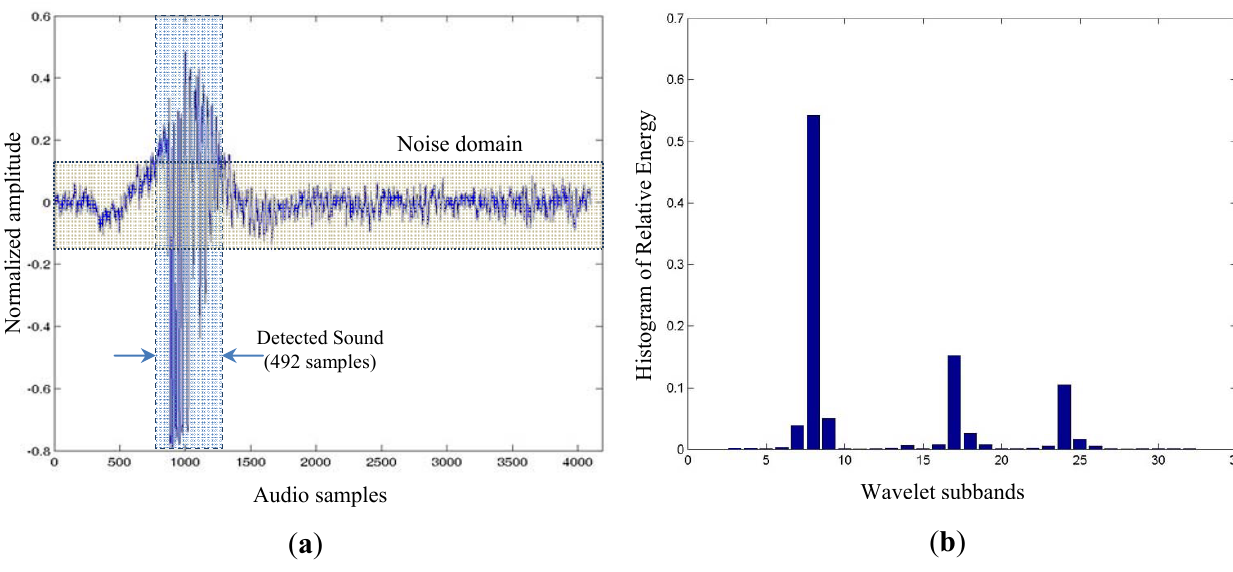
Figure 7. A 4096 sample window containing the RPW “eating” sound captured at 44.1 kHz sampling rate; ( a ) Temporal, and ( b ) frequency